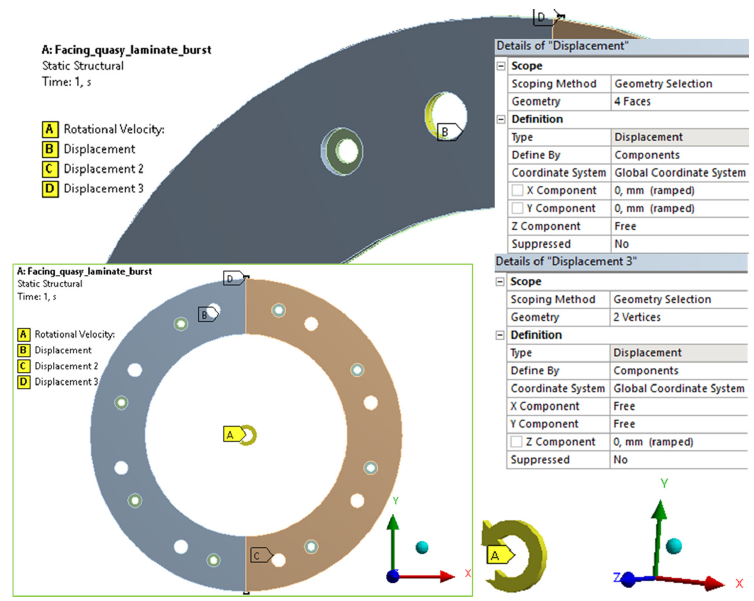
Figure A3. Applied load (rotational velocity, A) and boundary conditions (displacements, B–D).